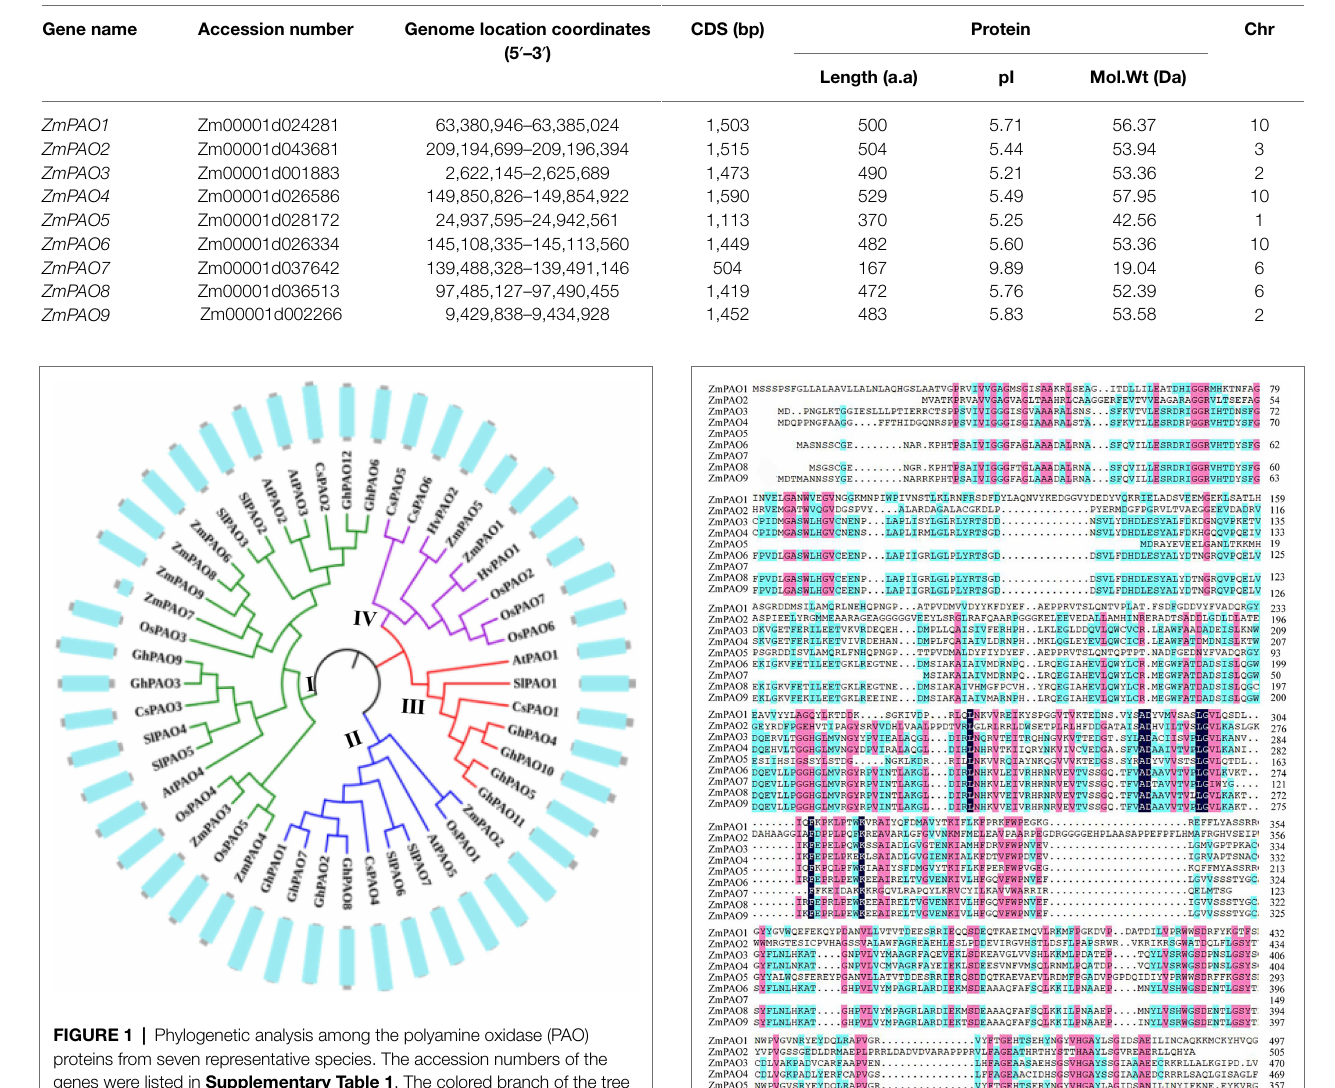
( Figure 2 ). The results demonstrated that ZmPAO4, ZmPAO6, and ZmPAO9 proteins contain SRL sequences. Moreover, ZmPAO3 protein contains CRT sequences, which share high homology with rice OsPAO4 protein. Thus, these results indicated that ZmPAO proteins in maize shared highly conserved homology with other plants in evolution.